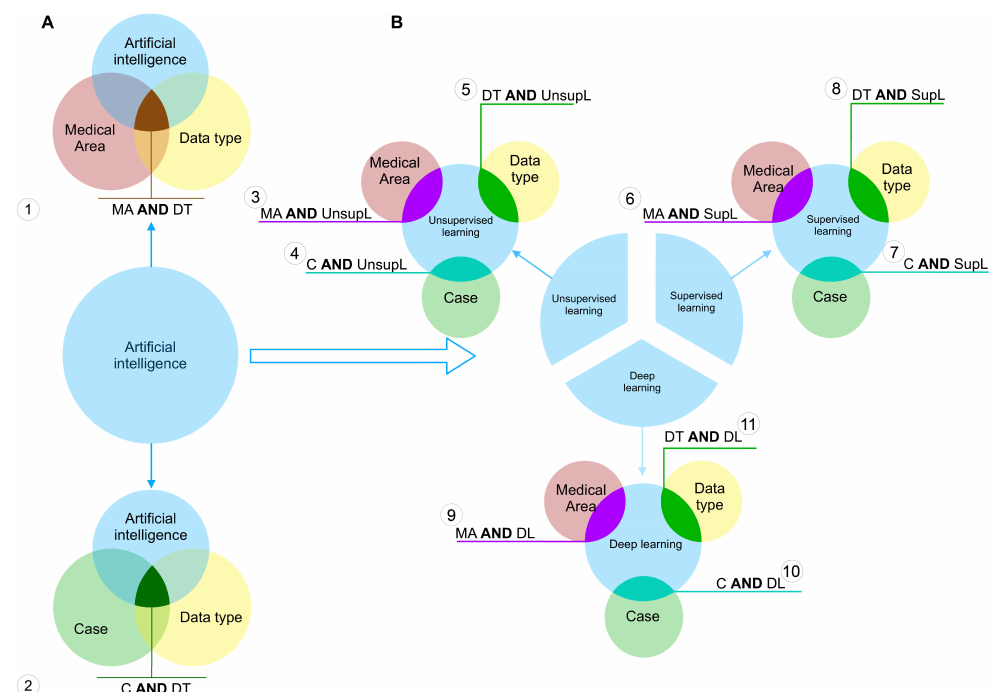
Figure 2. Query construction scheme. ( A )–the construction scheme of queries of the first type. ( B )–the construction scheme of queries of the second